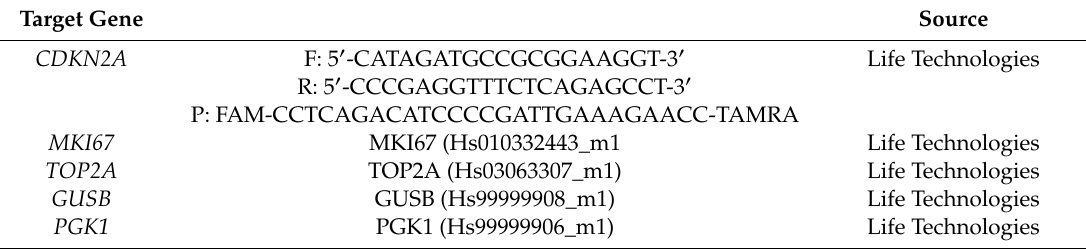
Table 1. Primers and probes used to detect the mRNA expression of the biomarkers analyzed in the